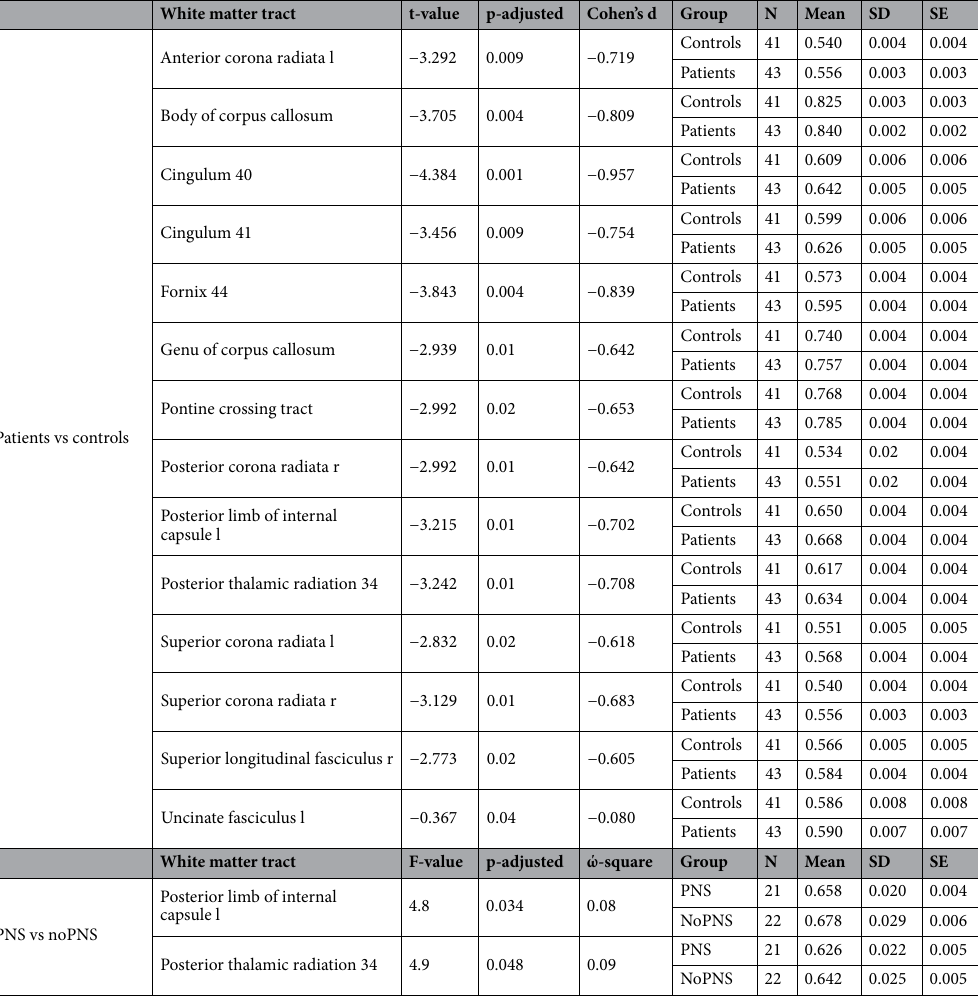
Table 4. Between group comparisons of the FA data